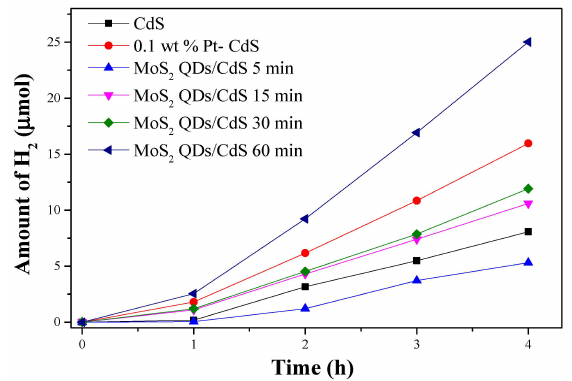
Figure 5. The amount of H 2 evolution on CdS, MoS 2 QDs/CdS (5 min,15 min,30 min 60 min), 0.1 wt % Pt-CdS catalysts under visible light irradiation (reaction conditions: 20 mg catalysts, 45 mL H 2 O containing 5 mL 0.02 M NaS and 0.025 M NaSO 3 , λ > 420 nm).